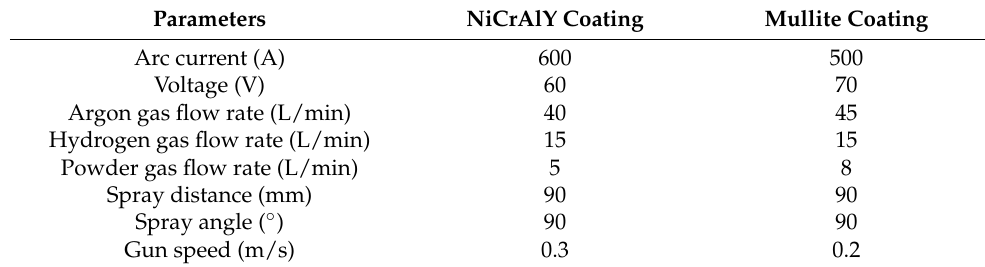
Table 3. APS parameters.